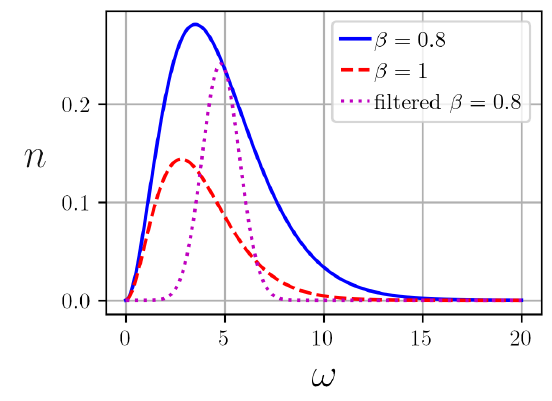
Figure 1. Planck density of black-body radiation for β = 0.8,1 and Gaussian filtering for β = 0.8 centered at ω = 5 with a variance σ 2 =